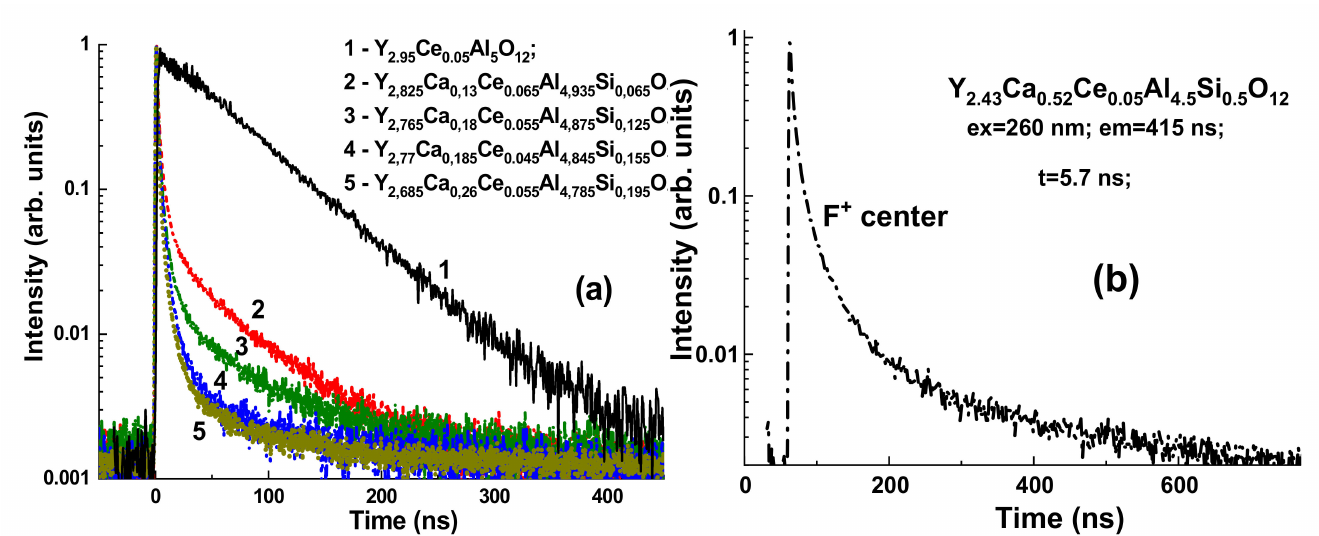
Figure 8. ( a )—RT decay kinetics of Ce 3+ luminescence at 530 nm in Y 3 − x Ca x Al 5-x Si y O 12 :Ce SCFs with different Ca and Si content (2–5) under excitation of PL at 340 nm and registration of PL at 530 nm in comparison with respective decay kinetics of Ce 3+ emission in YAG:Ce SCFs (1). ( b )—RT decay kinetics of F + luminescence at 415 nm in Y 2.43 Ca 0.52 Ce 0.05 Al 4.5 Si 0.5 O 12